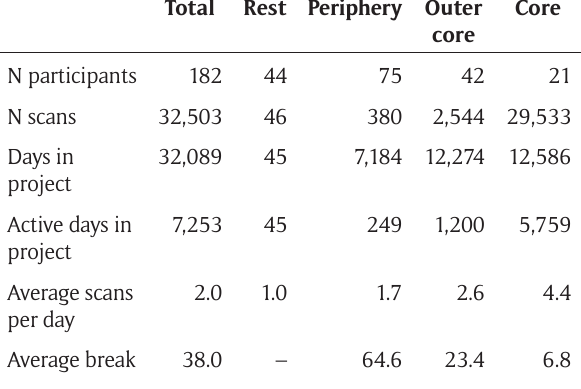
Table 2: Activity overview for the total of the “Yes, I do!”-